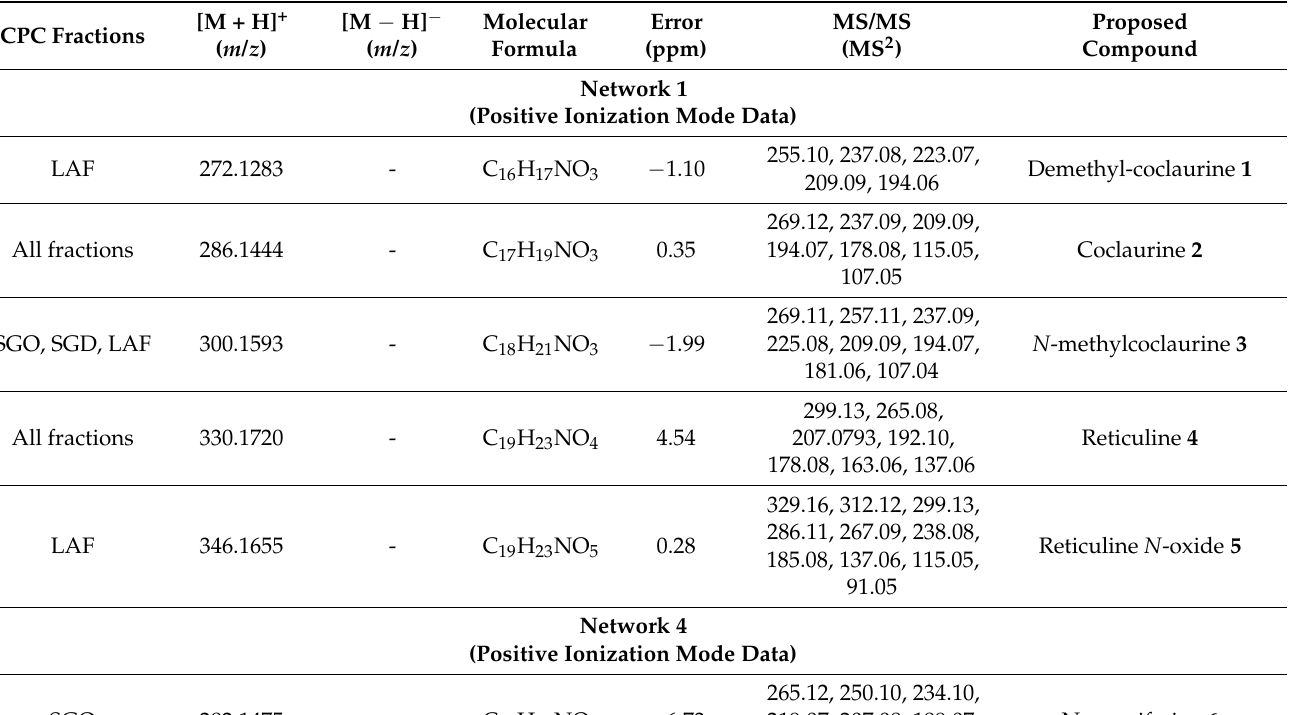
Table 1. LC-HRMS/MS data of annotated compounds in CPC bioactive fractions (MS/MS spectra in Supplementary Figures